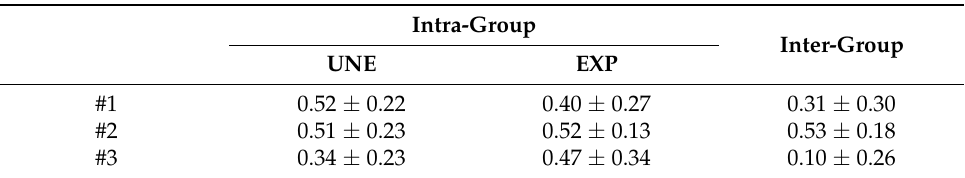
Table 1. Intra-group and inter-group similarity values (r) of muscle synergy vectors of weightlifters (EXP) and unexperienced participants (UNE).